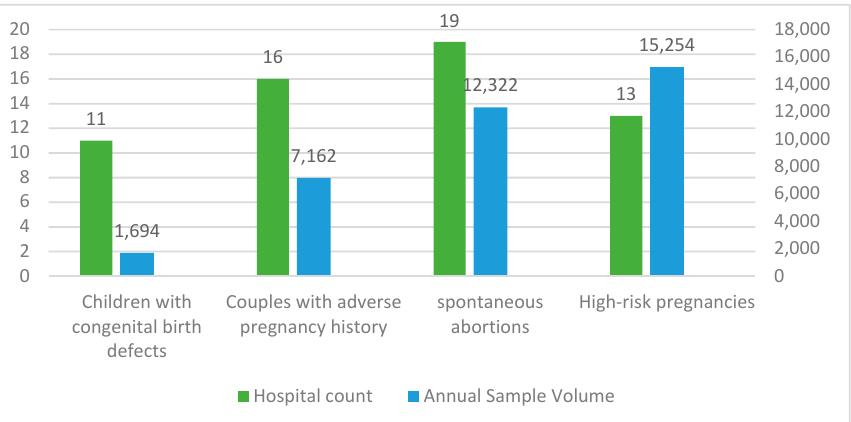
Figure 1. Compositions of patients’ referrals and annual sample volumes of low-pass WGS-based CNV analysis of 21 Chinese tertiary hospitals enrolled in this survey. The green bars illustrate the number of hospitals that provided low-pass WGS-based CNV analysis for each type of referral, which corresponds to the left axis; the blue bars illustrate the annual sample volumes of each type of referral, which corresponds to the right axis.